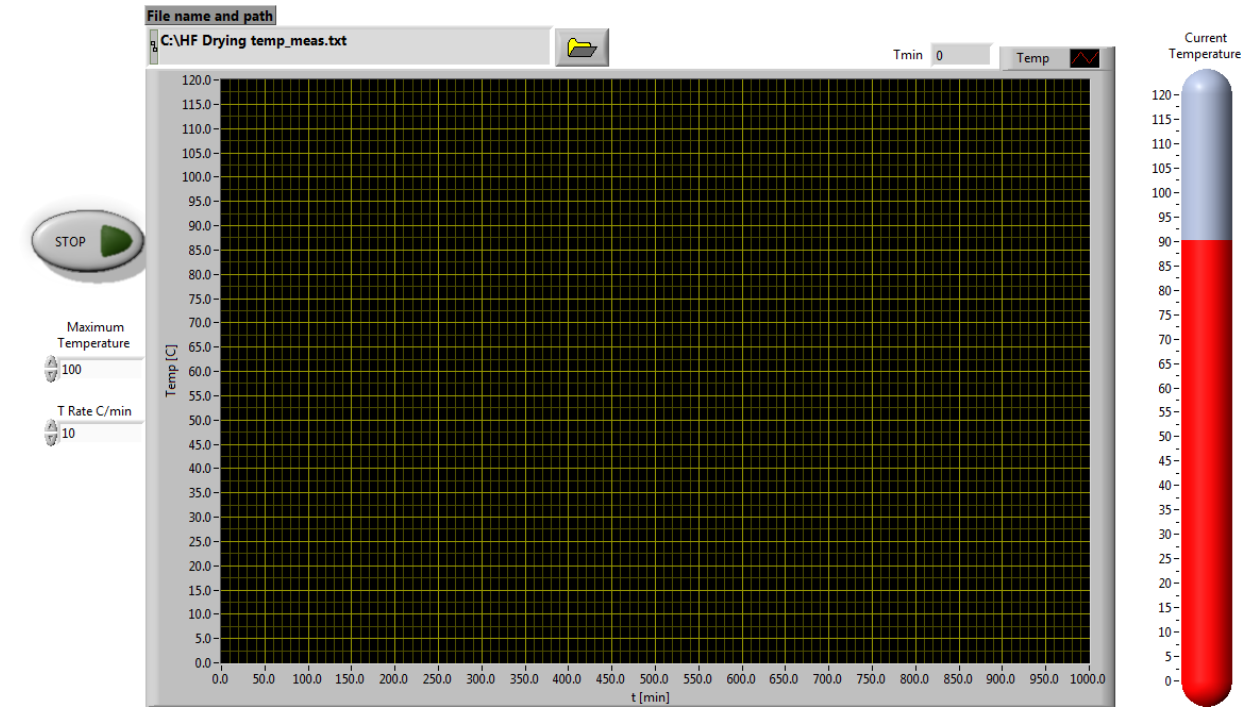
Figure 6. Temperature control front panel.